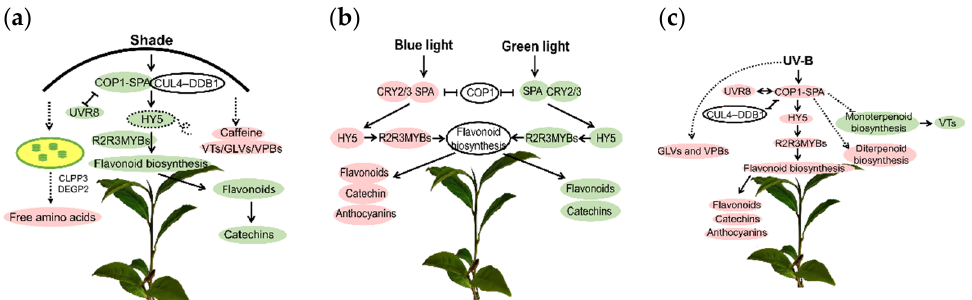
Figure 2. Effects of shade ( a ), blue and green light ( b ), and UV-B ( c ) on tea metabolites. CLPP3, ATP- dependent Clp protease proteolytic subunit 3; COP1, CONSTITUTIVE PHOTOMORPHOGENIC 1; CRY, cryptochrome; CUL4, CULLIN4; DDB1, DET1-Damaged DNA Binding Protein 1; DEGP2, protease Do-like 2; HY5, ELONGATED HYPOCOTYL 5; SPA, SUPPRESSOR OF PHYA; UVR8, UV RESISTANCE LOCUS 8.